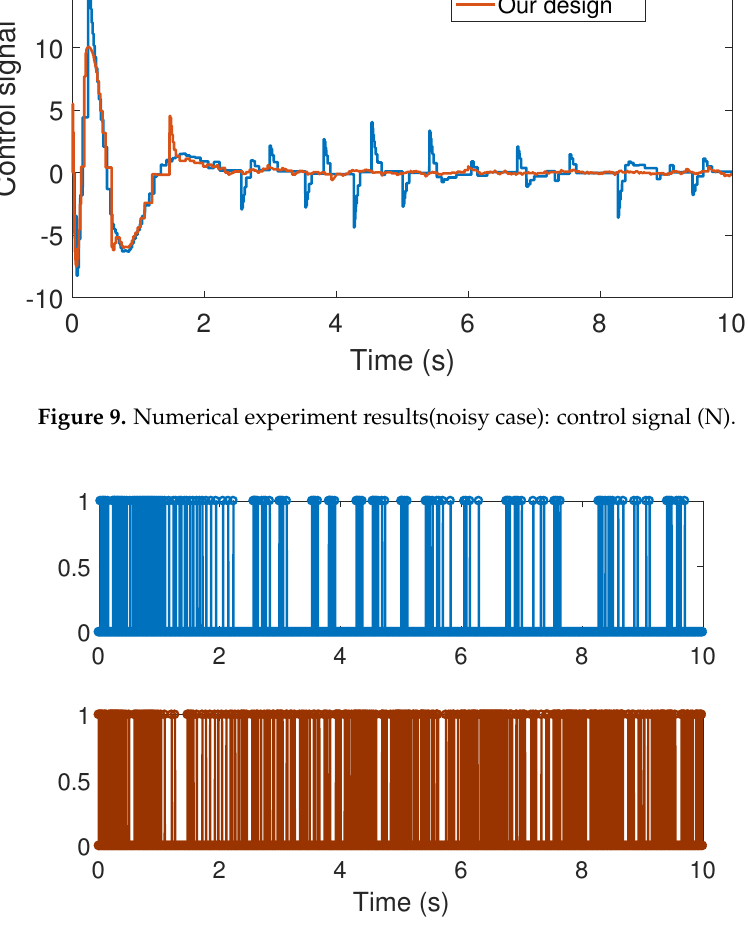
Figure 10. Numerical experiment results (noisy case): sampling instants; top corresponds to the cited reference case and bottom to our design